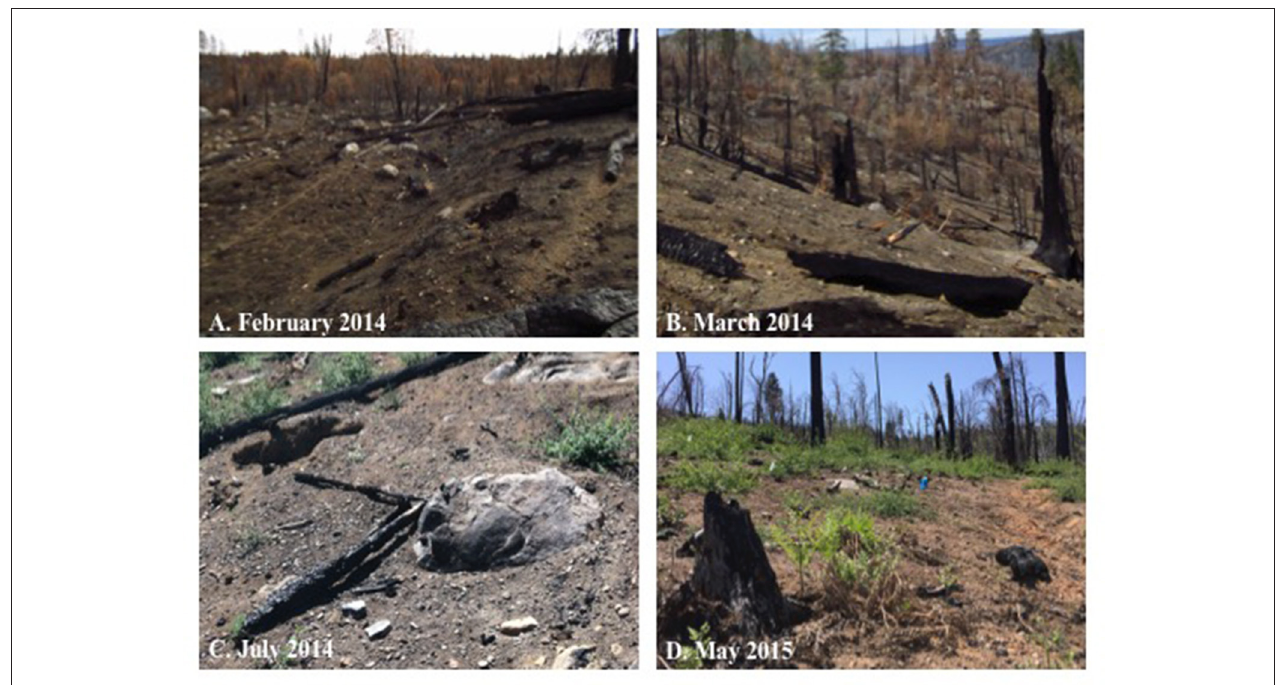
FIGURE 3 | Erosion in upland temperate forests is dependent upon precipitation and topography. This progression of photographs from the Rim Fire (2013, in Yosemite National Park and Stanislaus National Forest in California, USA) illustrates the significant loss of PyC post-fire in a high-severity burn area and post-fire vegetation regrowth (all photos, R. Abney). The Rim Fire began in August of 2013 and was contained in November of 2013, with the aid of snowfall. The picture in (A) (from February 2014, 3 month’s post-fire) illustrates the significant PyC layer remaining after the first snowmelt. The picture in (B) from March 2014 is the remaining PyC after the first major rainfall post-fire. The soil color is considerably lighter (3–5/1 5YR dark gray compared with 2.5/1 5YR black), which is evidence of loss (erosion) of highly charred material (PyC). The pictures in (C,D) have considerably less PyC covering the soil surface and illustrate the beginnings of vegetation regrowth based on ocular assessment after the Rim